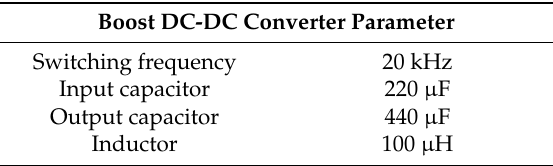
Table 2. Boost DC-DC converter design parameter.